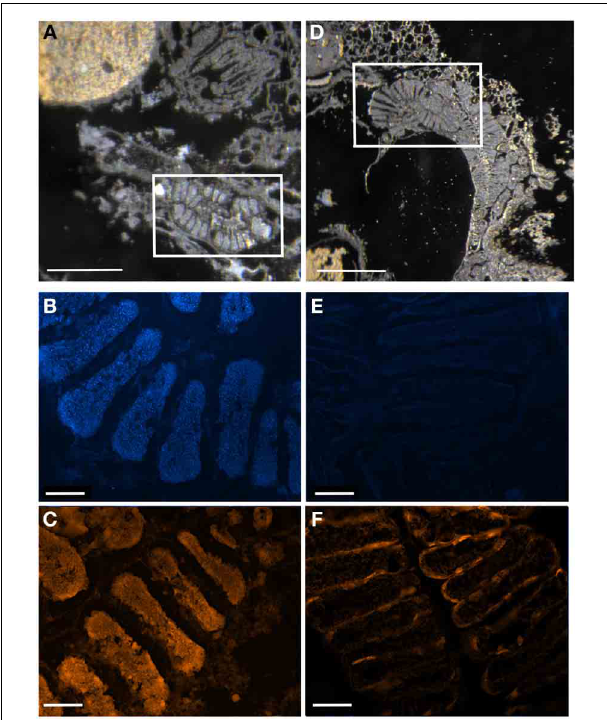
FIGURE 10 | Digestive ceca of symbiotic vs. symbiont-deprived 5th instar Sibaria englemani nymphs. (A–C) Light microscopy, DAPI, and FISH microscopy, respectively, of the ceca of a symbiotic nymph, showing dense bacteria within the crypt spaces. (A) shows the non-symbiont containing sac-like midgut region (M3), as described in Futahashi et al. (2013), at top left (D–F) Light microscopy, DAPI, and FISH microscopy, respectively, of the ceca of a symbiont-deprived nymph, showing lack of cecal bacteria and visual differences in gross ultrastructure. (A,D) Light images of sections through the midgut ceca, embedded in, and then removed from, Steedman’s wax prior to hybridization. Boxes denote areas of subsequent DAPI and fluorescent 16S rRNA probing. (B,E) Fluorescent images showing boxed regions in (A,D) counter-stained with DAPI, observed in blue. (C,F) Fluorescence in situ hybridization (FISH) microscopy of the boxed regions in (A,D) , hybridized with the Eub338 probe set labeled with Cy3, shown in orange. Light image scales, 2mm. Fluorescent image scales, 20 µ m.